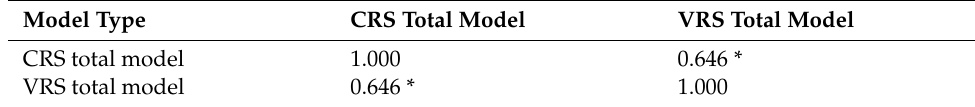
Table 4. Spearman-rank correlation test.